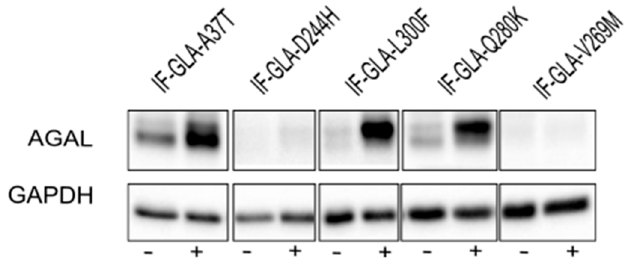
Figure 6. Combined treatment with galactose and curcumin treatment increased AGAL. IF-GLA and IF-GLA-MUTs were treated for 48 h with 100 mM galactose in the presence or absence of 20 µ M curcumin. AGAL was visualized via immunoblotting on cell protein extracts. The figure shows IF-GLA-MUTs treated with 100 mM galactose in the presence (+) or the absence ( − ) of 20 µ M curcumin.